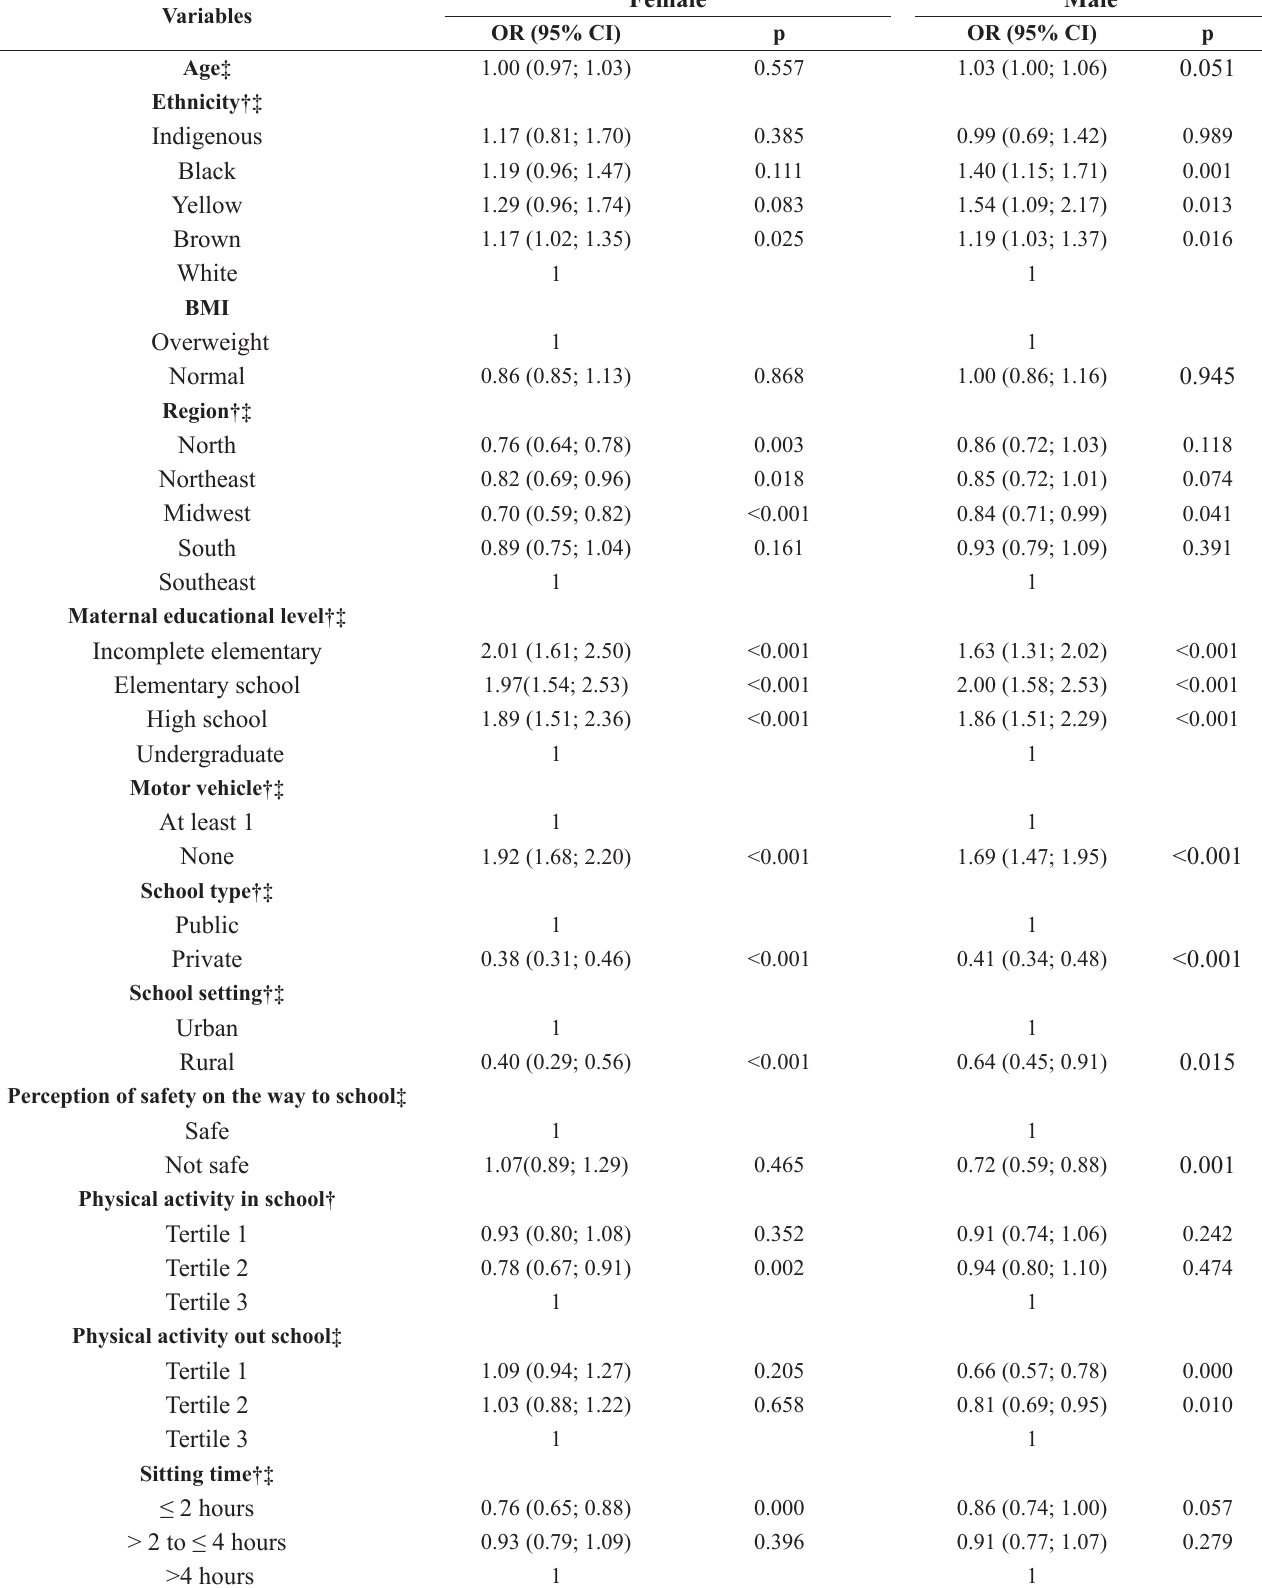
Table 2- Crude logistic regression for correlates of active commuting to schools among Brazilians adolescents.